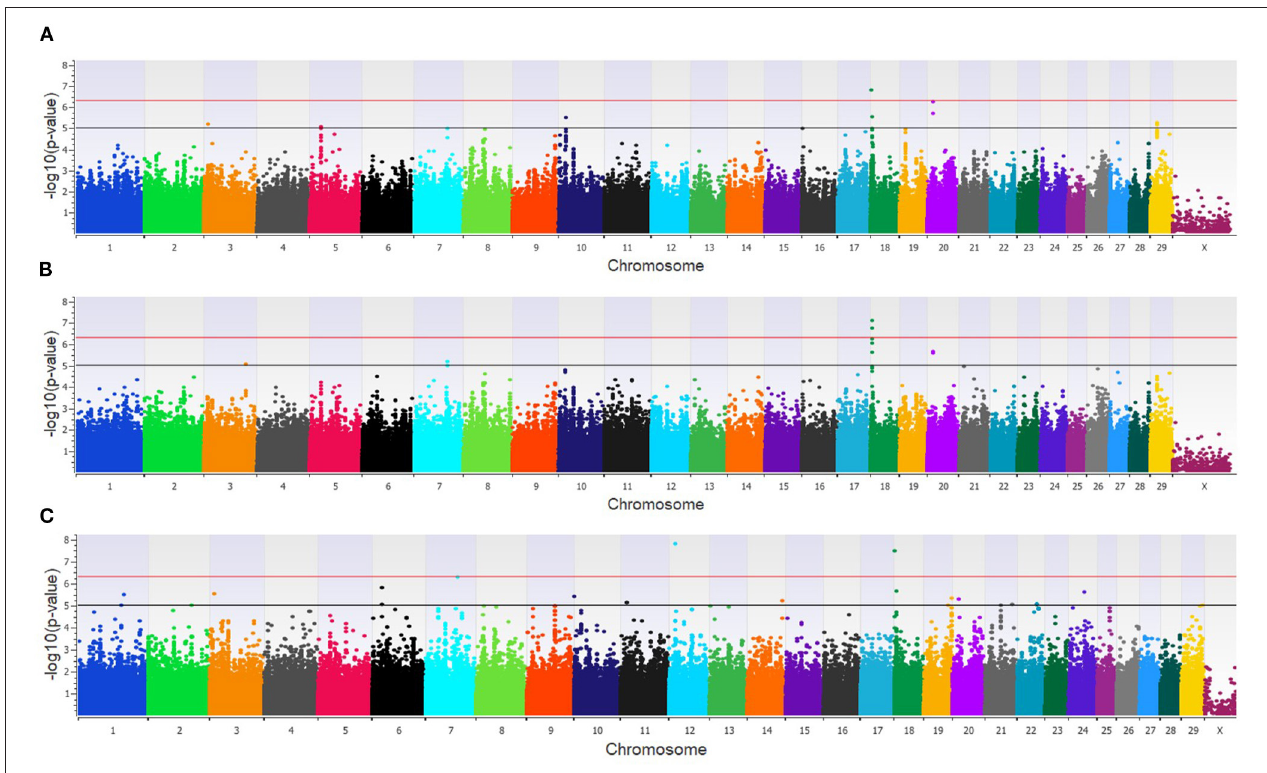
FIGURE 2 | Manhattan plots identifying loci associated with bovine coronavirus infection in additive (A) , dominant (B) , and recessive (C) EMMAX models for the feedlot population. Single-nucleotide polymorphisms (SNP) are represented by a single dot. Bovine chromosomes are listed on the x-axis. SNPs located between the black and red lines provide evidence of moderate association ( p between 1 × 10 − 5 and 5 × 10 − 7 ), and SNPs above the red line provide evidence of strong association ( p < 5 × 10 − 7 ) based on the Wellcome Trust Case Control Consortium ( 24)